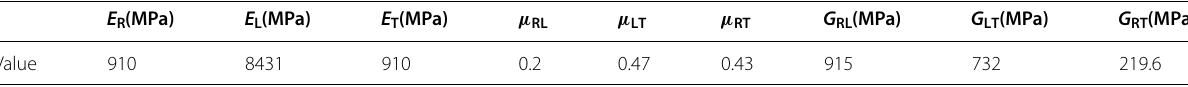
Table 6 Elastic constitutive parameters of